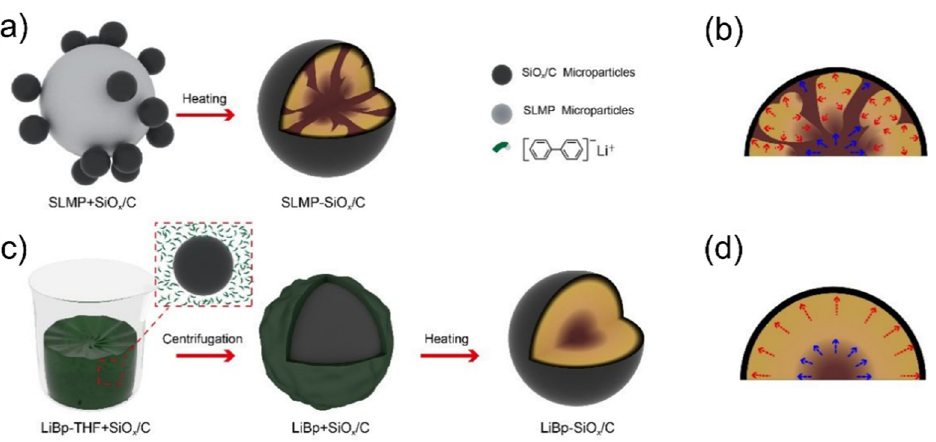
Figure 5. Schematic drawing illustrating the synthesis process and internal stresses for ( a , b ) SLMP-SiO x /C and ( c , d ) LiBp-SiO x /C. Reproduced with permission from ref. [34]. Copyright 2020, ACS Pub- lications.